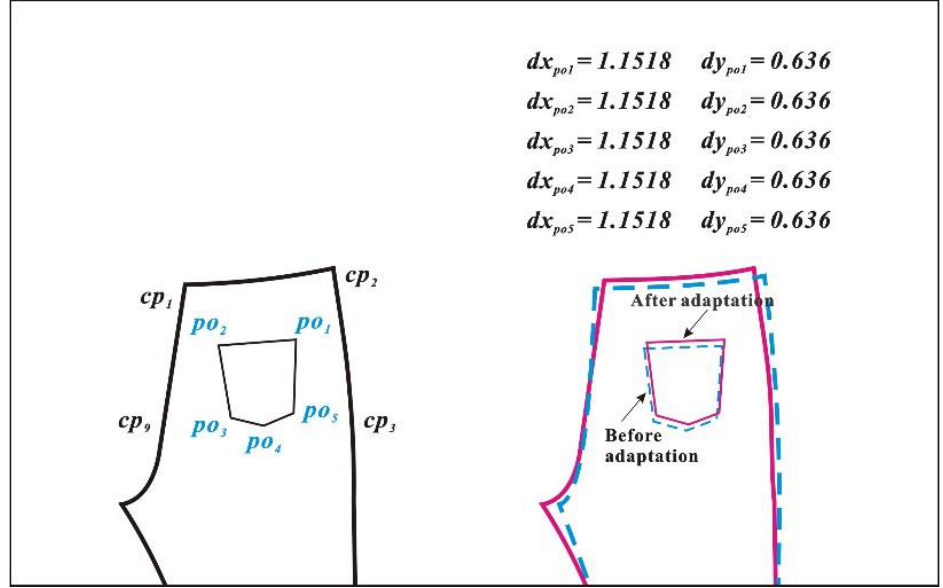
Figure 11. Associated adaptation of the pockets.